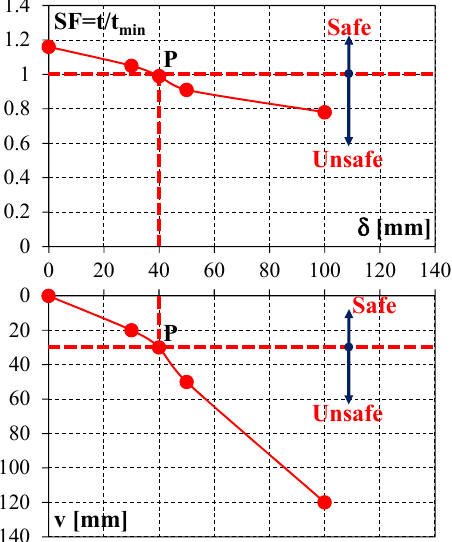
Figure 8. Plot of the geometrical safety factor SF ( top ) and of the geometrical vertical displacement v of the crown of the arch ( bottom ) versus the horizontal settlement δ imposed to the right constraint of the arch in the load test #2 for the arch in